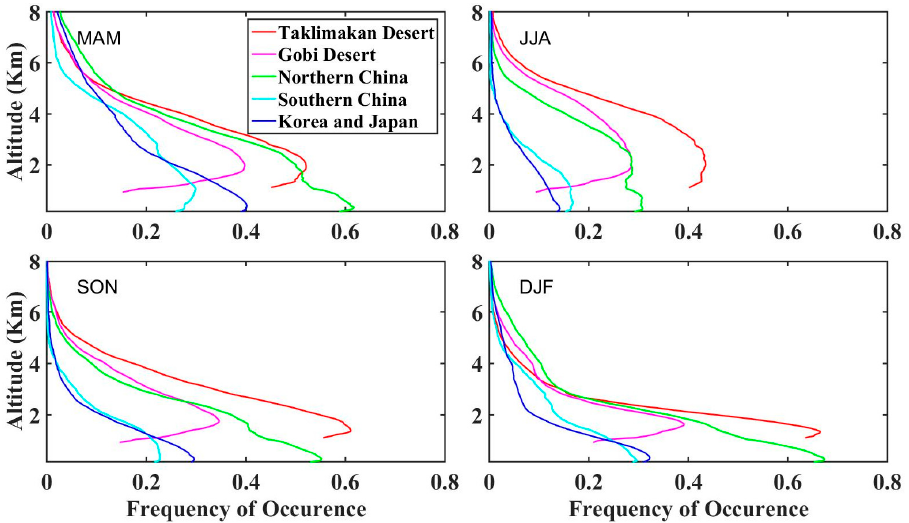
Figure 3. Vertical distribution of the frequency of dust occurrence over: (1) the Taklimakan Desert (red line), (2) the Gobi Desert (magenta line), (3) Northern China (green line), (4) Southern China (light blue line) and (5) Korea-Japan (dark blue) based on CALIPSO data.